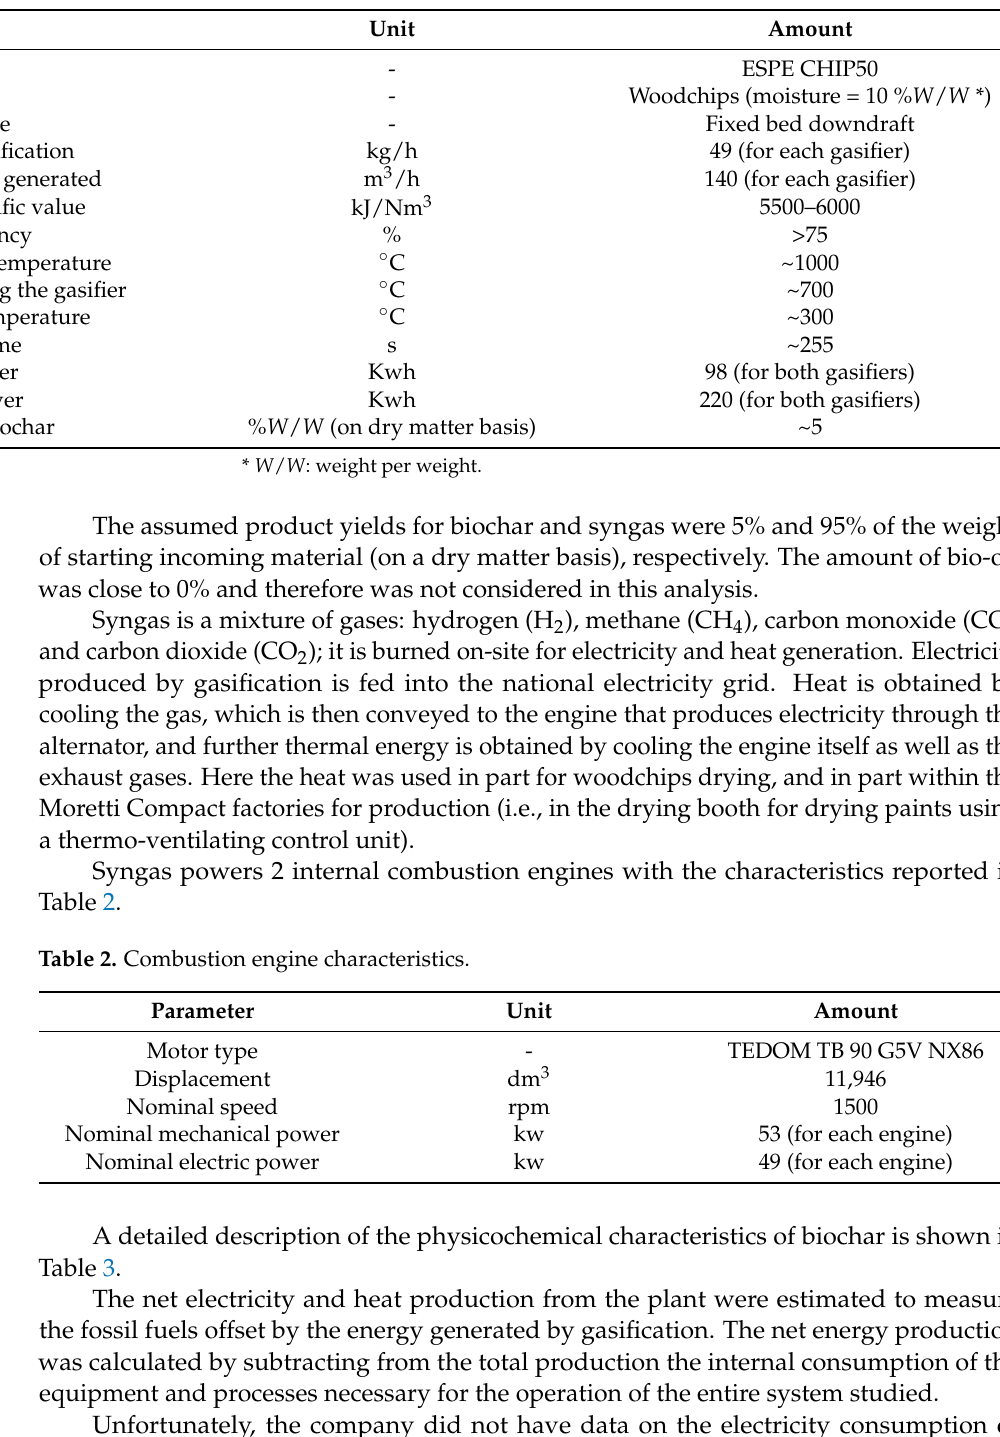
Table 1. Technical parameters of the gasification